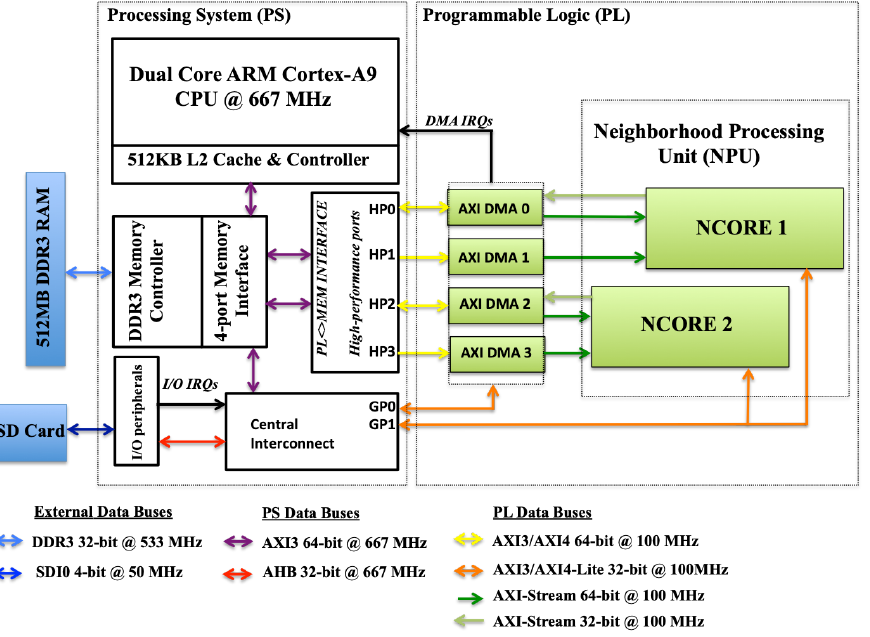
Figure 14. Hardware implementation in the Zynq-7000